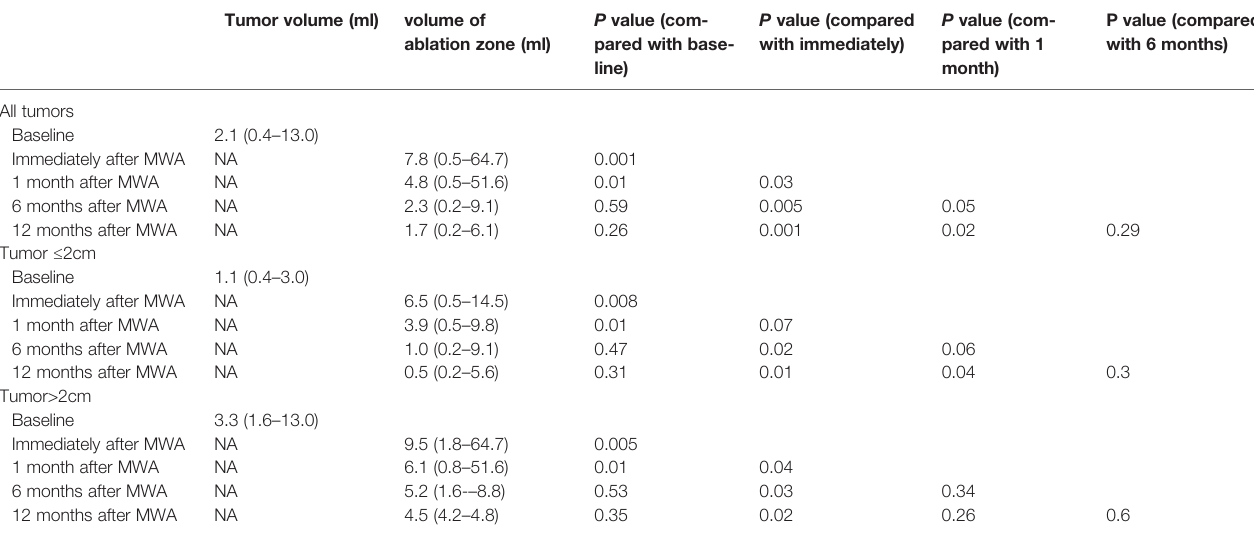
TABLE 5 | Volume change of tumor and ablation zone.